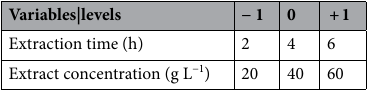
Table 1. Levels and variables used in the experimental